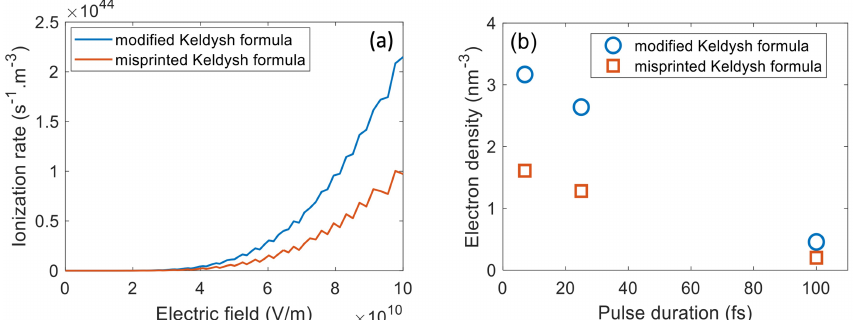
Figure 9. Comparison of ( a ) photoionization rates and ( b ) electron densities at LID threshold calcu- lated by the uncorrected and corrected/modified Keldysh formulae for fused silica. The incident fluence is 1.15, 1.90, and 2.50 J/cm 2 for pulse duration of 7, 25, and 100 fs, respectively. λ = 800 nm. The pulses are s -polarized.